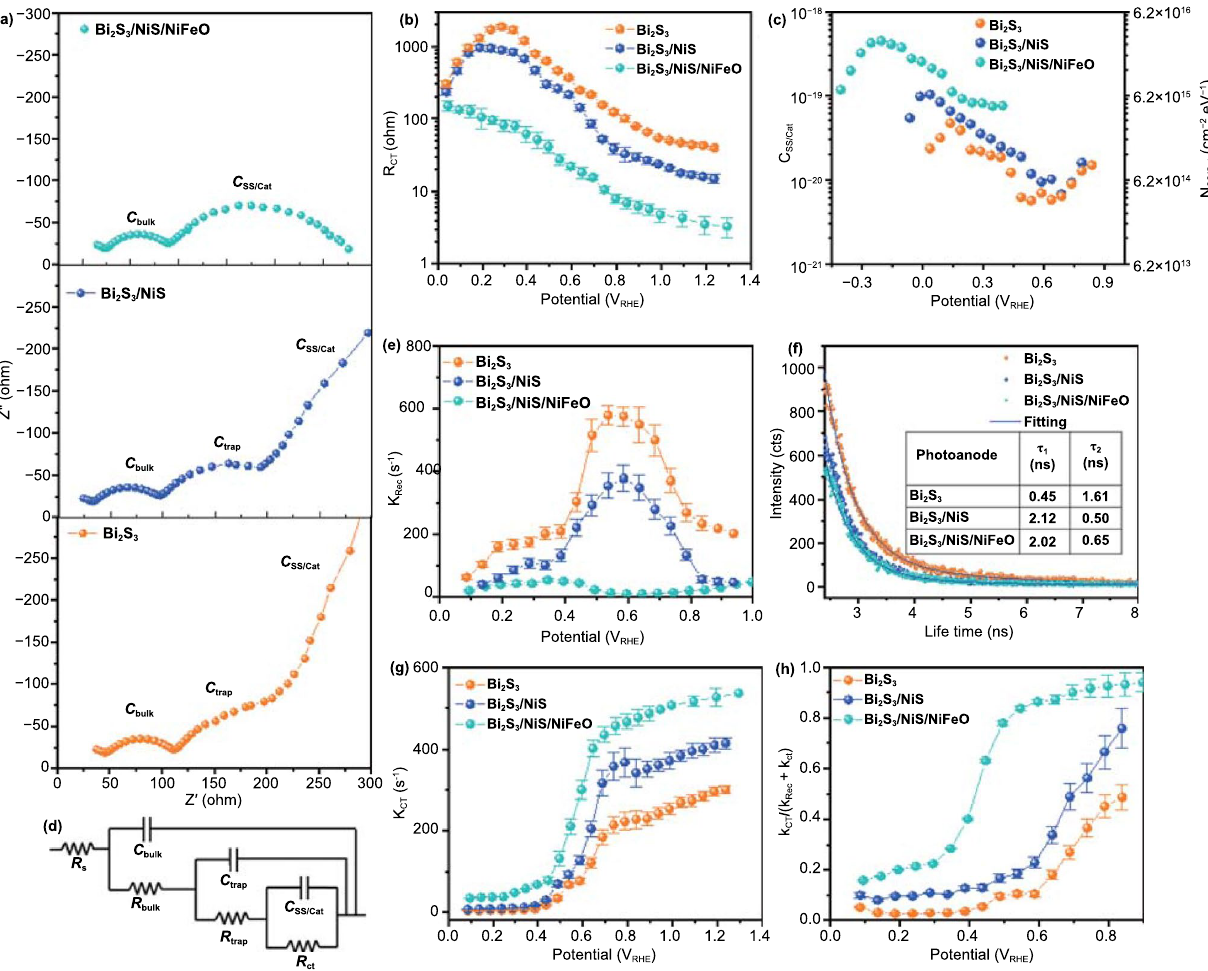
Fig. 4 a Nyquist plot of bismuth sulfide photoanodes at 0.30 V RHE , b interface charge transfer resistance ( R ct ), and c distribution of C SS/cat and N SS calculated from PEIS measurements at various potentials under illumination in 0.25 M Na 2 S electrolyte, d Electronic circuit used to fit the PEIS data, e charge recombination rate constant ( k rec ), f TRPL transients, where solid blue line represents a bi‑exponential fitting (table: fitted values), g charge transfer rate constant ( k ct ), and h overall quantum efficiency of